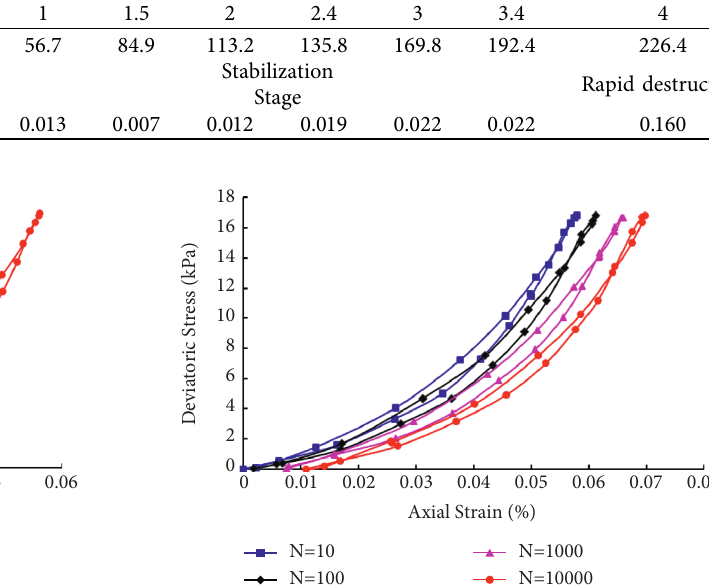
Figure 6: Hysteretic curve with different dynamic stress (cycle times N � 8000).